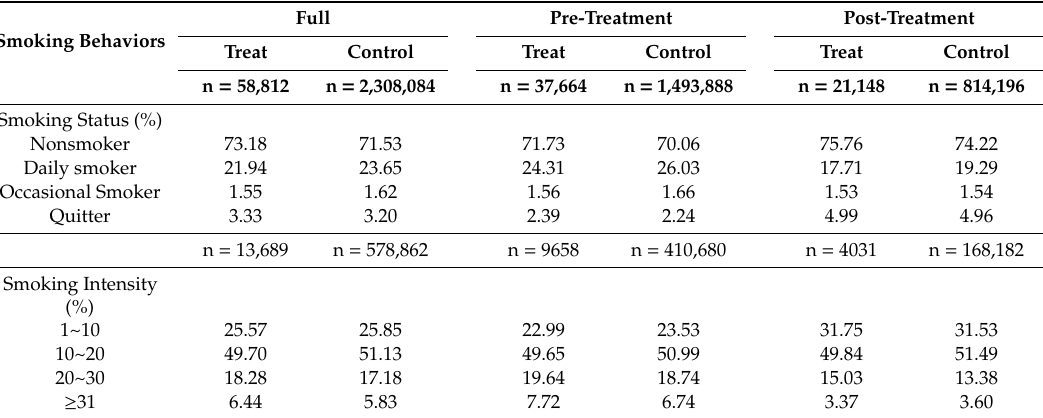
Table A2. Descriptive statistics of smoking